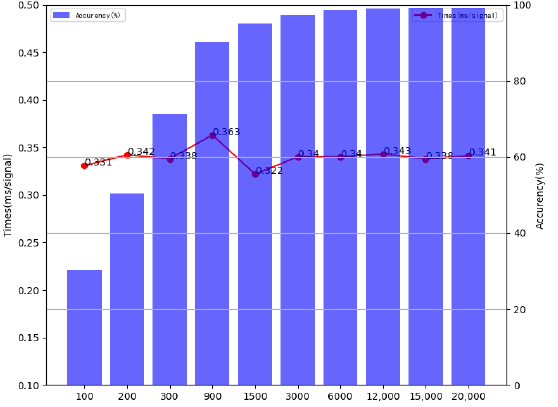
Figure 13. Diagnostic results for different data